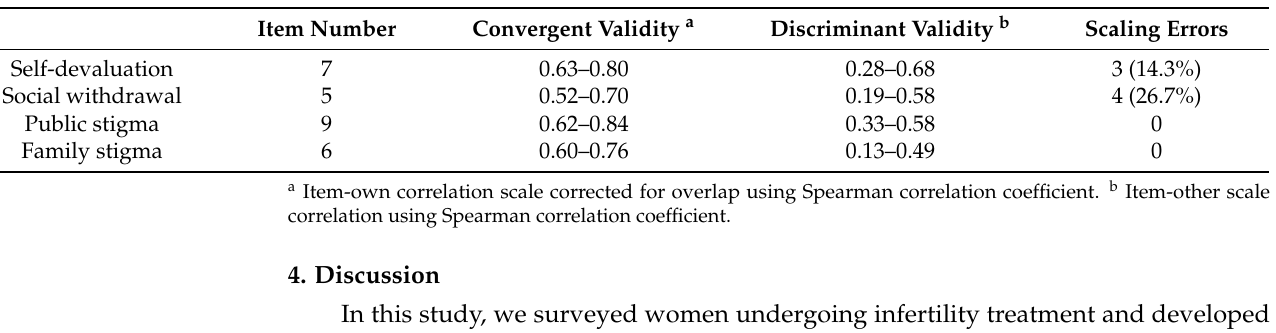
Table 8. Multitrait scaling analysis between scale items on the ISS ( N =